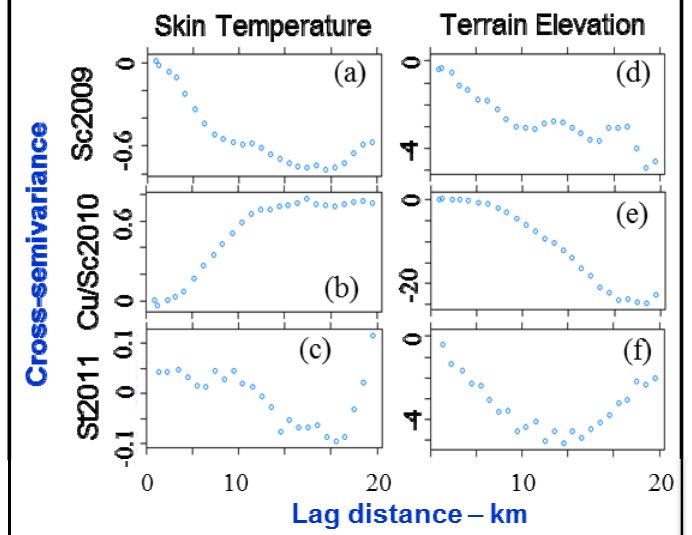
Figure 14. Cross-variograms indicating the spatial correlation for skin temperature and rain rate ( a – c ) and terrain elevation and rain rate ( d – f ) for three rain